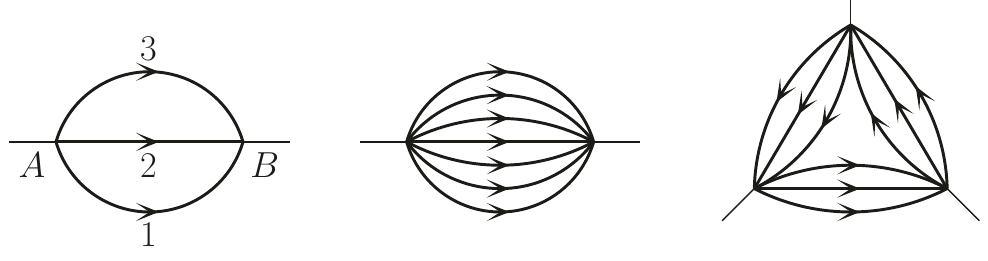
Figure 3 . Multiloop diagrams with stacks of internal legs connecting